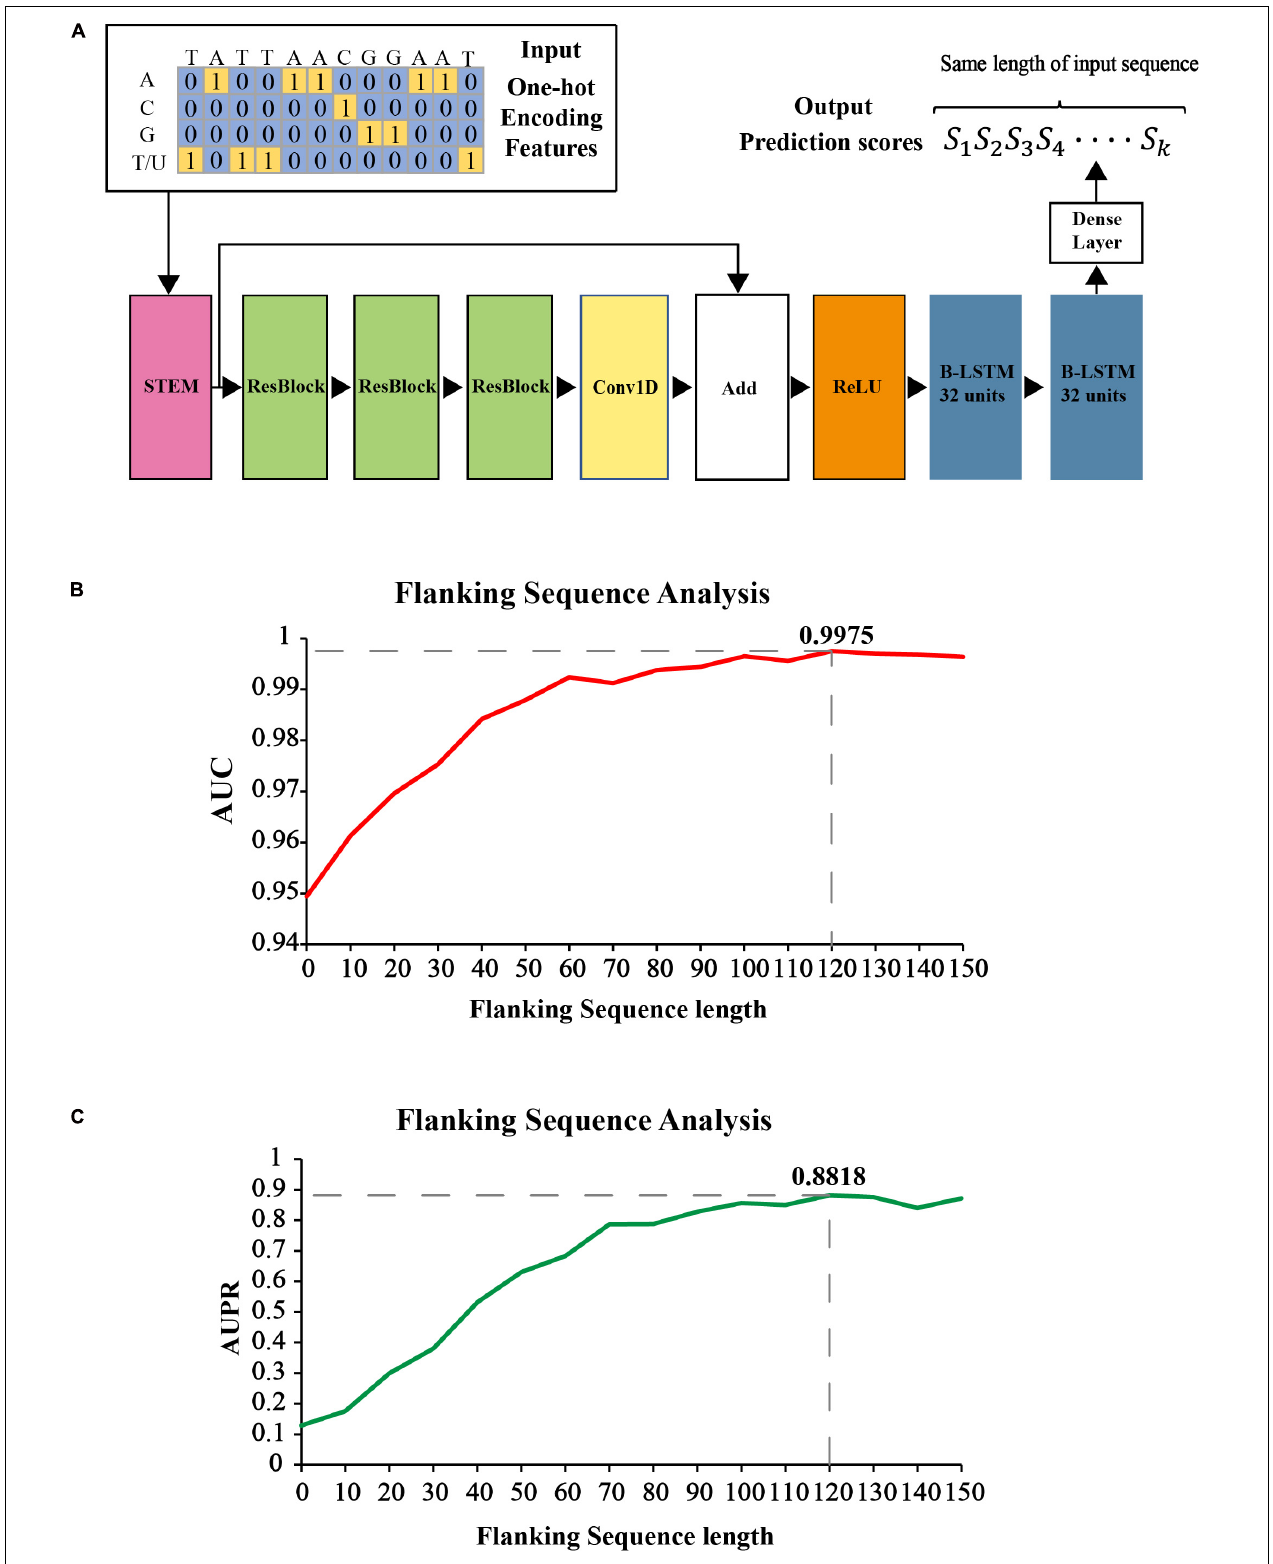
FIGURE 2 | The construction of prediction model in DeepOMe. (A) Network architecture of the DeepOMe prediction model. Flanking sequence selection under 4-fold cross-validation by AUPR (B) and AUROC (C) .